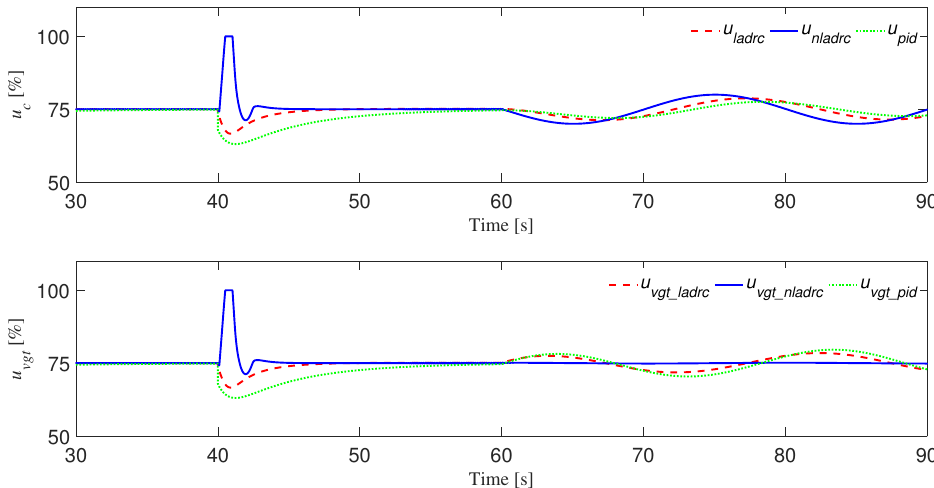
Figure 10. Output signal u c of controller and input signal u vgt of VGT valve.